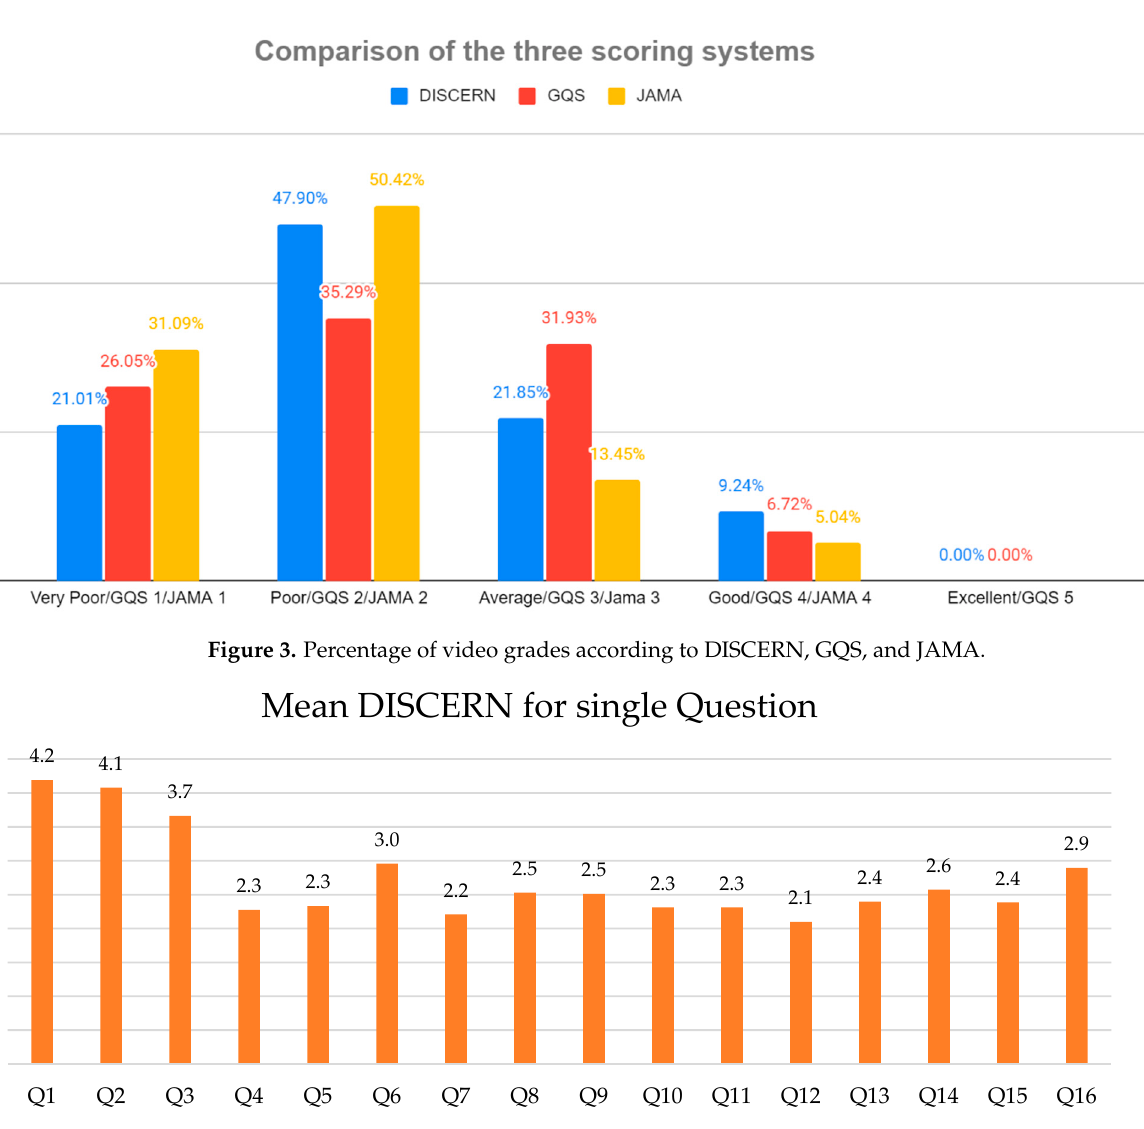
Figure 4. Mean score for each DISCERN question.